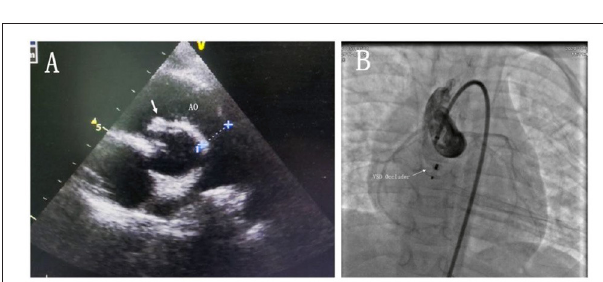
FIGURE 2 | (A) Transthoracic echocardiogram obtained in the aortic long-axis view showing that the occluder was well (white arrow). (B) Cine static image front view showing the ventricular septal defect occluder in place. AO, aorta; VSD occluder, ventricular septal defect